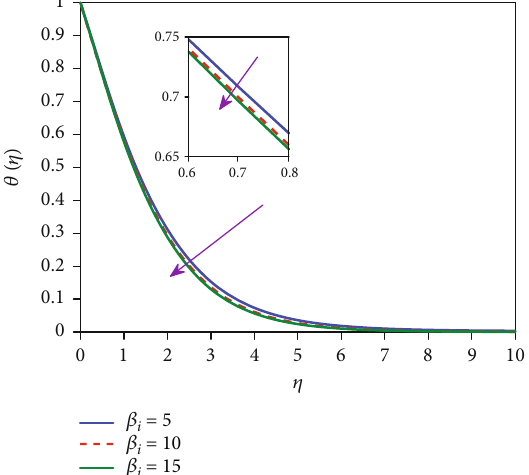
on the concentration ϕ ð η Þ . i